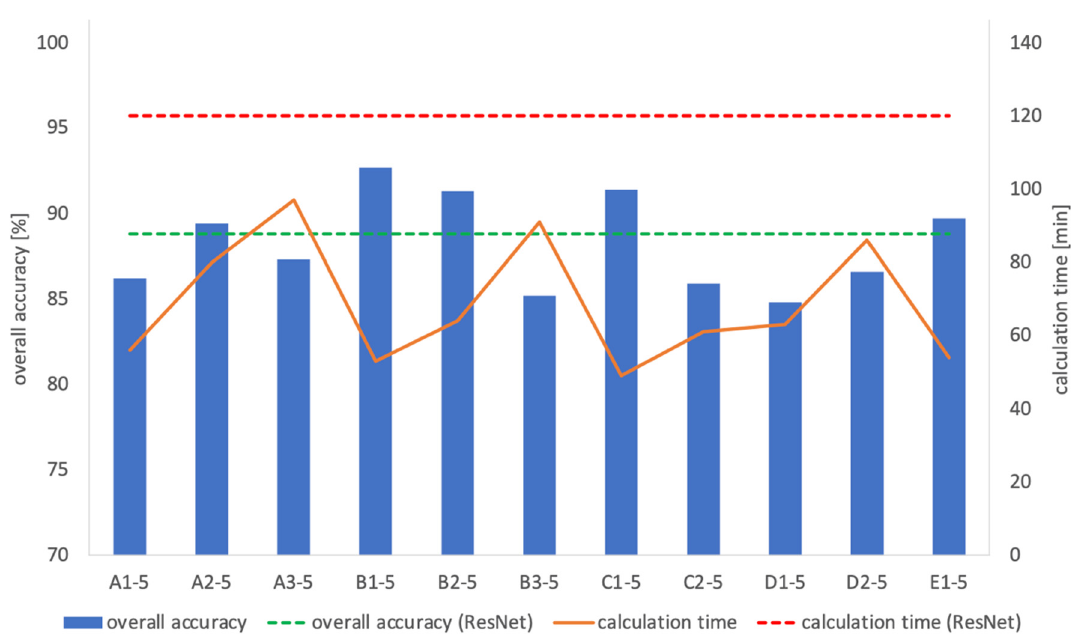
Figure 6. Overall accuracies and calculation times of the models with combination (the filter size of max-pooling: (5, 5)).